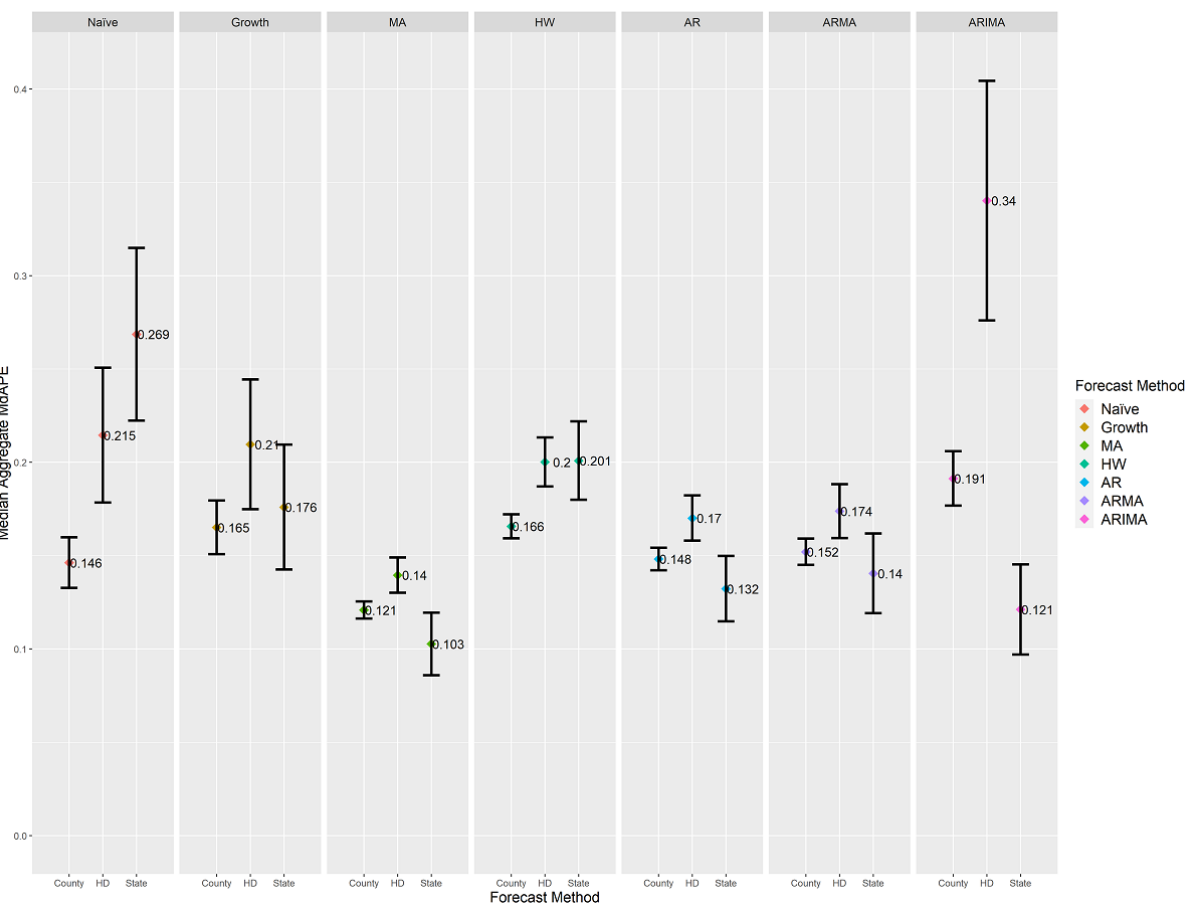
Figure 5. Aggregated median MdAPE values and 95% CI ranges at the county, health district (HD), and state levels differentiated by forecasting method. Comparing CI ranges for a forecast method across each geographic level reveals statistically significant differences in median values for the forecasting method due to geographic scale. Nonoverlapping CI ranges indicate statistically significant differences at a P value of .01. MdAPE provides a comparison within each forecast method separately, not a comparison across different methods. AR: autoregressive; ARIMA: autoregressive integrated moving average; ARMA: autoregressive moving average; HW: Holt-Winters; MA: moving average; MdAPE: median absolute percentage